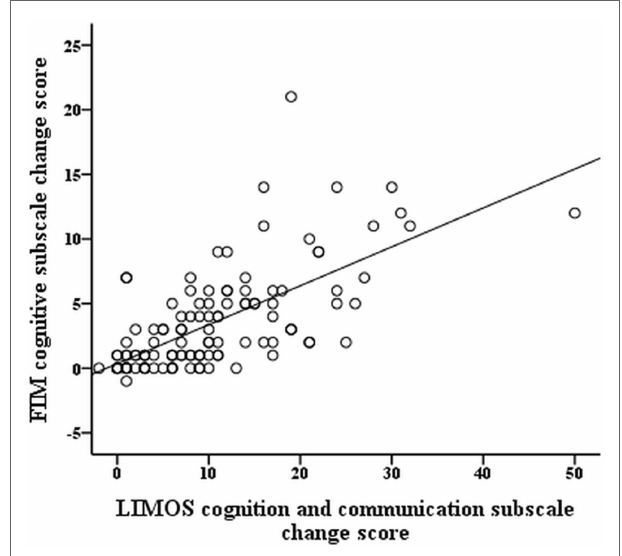
FigUre 2 | liMOs cognition and communication subscale change correlates significantly with a change in the FiM cognition subscale .